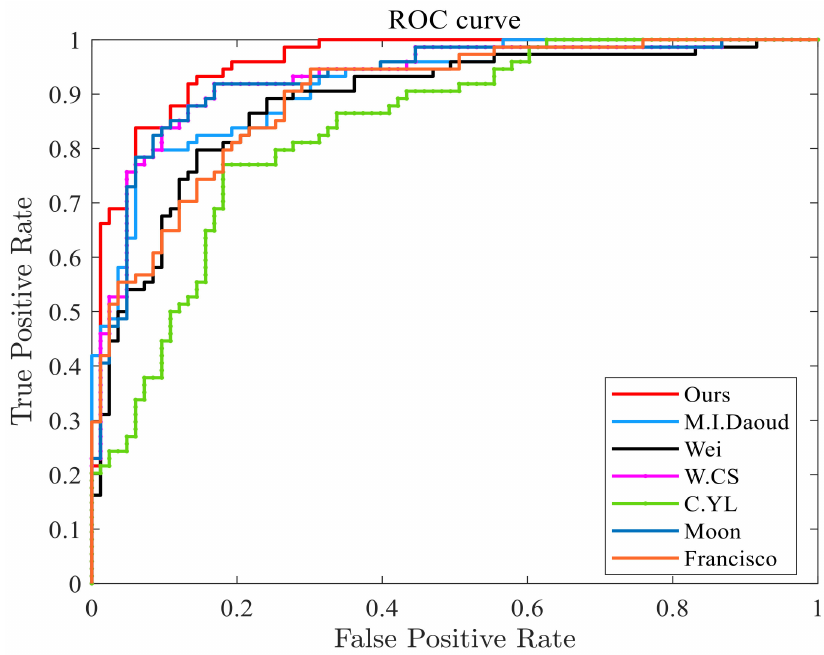
Figure 7. The ROC curves of different related existing methods. Table 5. The performance comparison of the proposed method and the related existing methods.